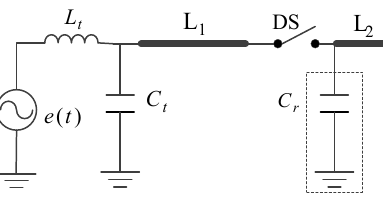
Figure 10. A simplified GIS (gas insulated switchgear ) for very fast transient overvoltage (VFTO) simulation.